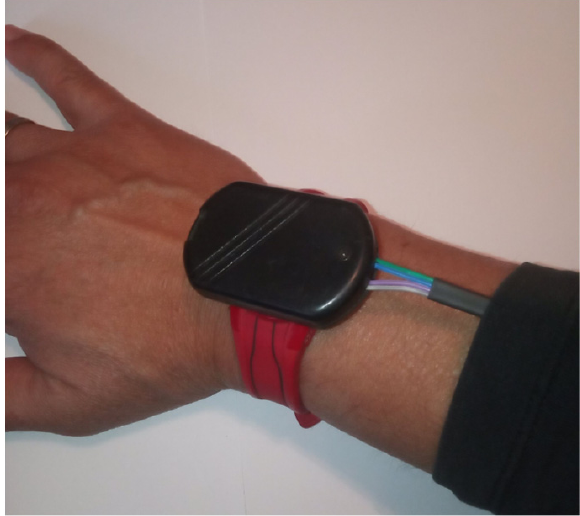
Figure 4 . The sensing device on the participant’s wrist .